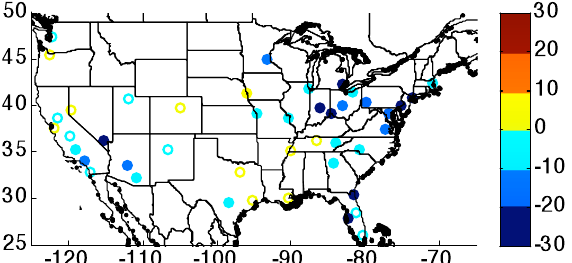
Fig. 7. Percent change in NO 2 from non-mobile sources for 2005– 2011 (derived from OMI observations) in major cities of the US. Open circles show where the change is < ± 5% while the solid dots show where the change is ≥± 5%.